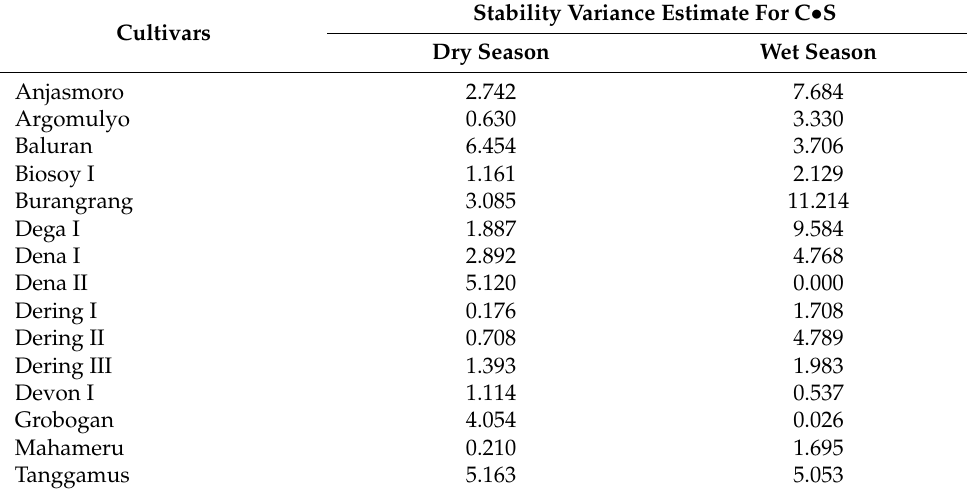
Table 8. Stability variance estimates (10 − 1 kg 2 ha − 2 ) for the Shukla model.